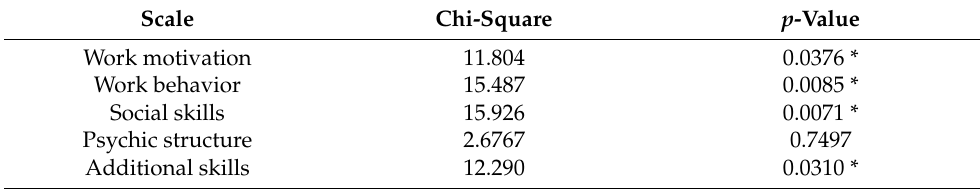
Table 13. Kruskal–Wallis test statistics when the sample is differentiated by the area of knowledge. Scale Chi-Square p -Value Work motivation 11.804